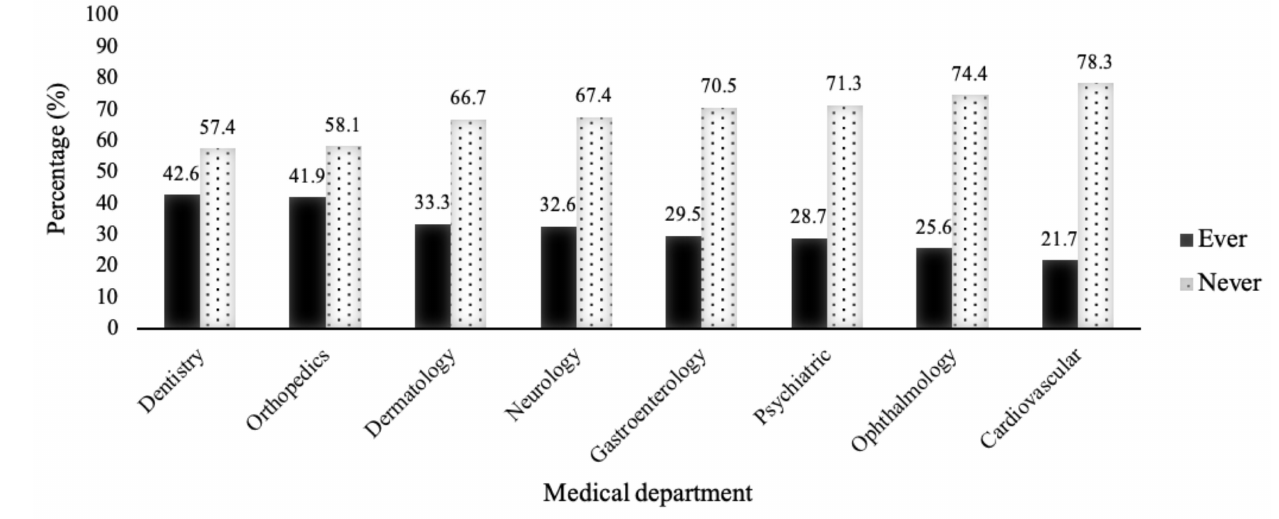
Figure 1. Distribution of medical department use in homeless